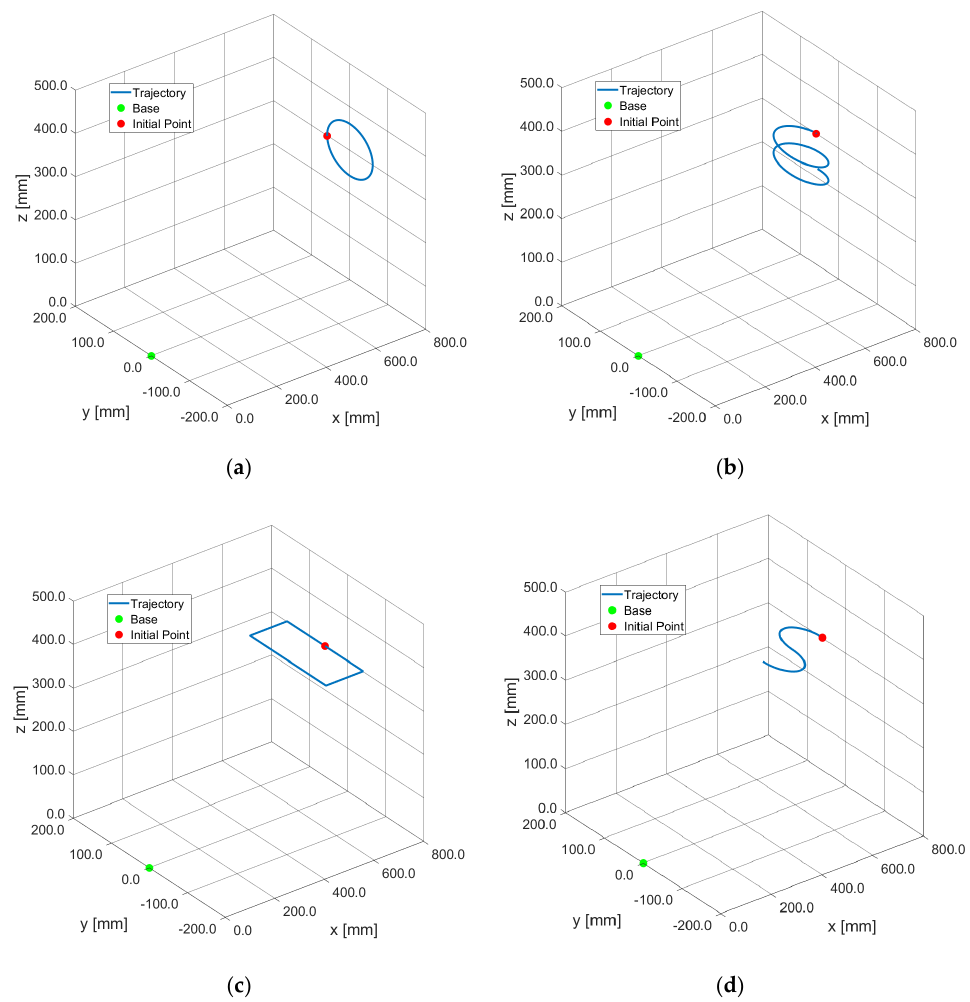
Figure 2. Implemented validation trajectories: Circle in the Y-Z plane ( a ), Spiral X-Y along Z direction ( b ), Rectangle in the X-Y plane ( c ), S-shape in the X-Y plane ( d ).